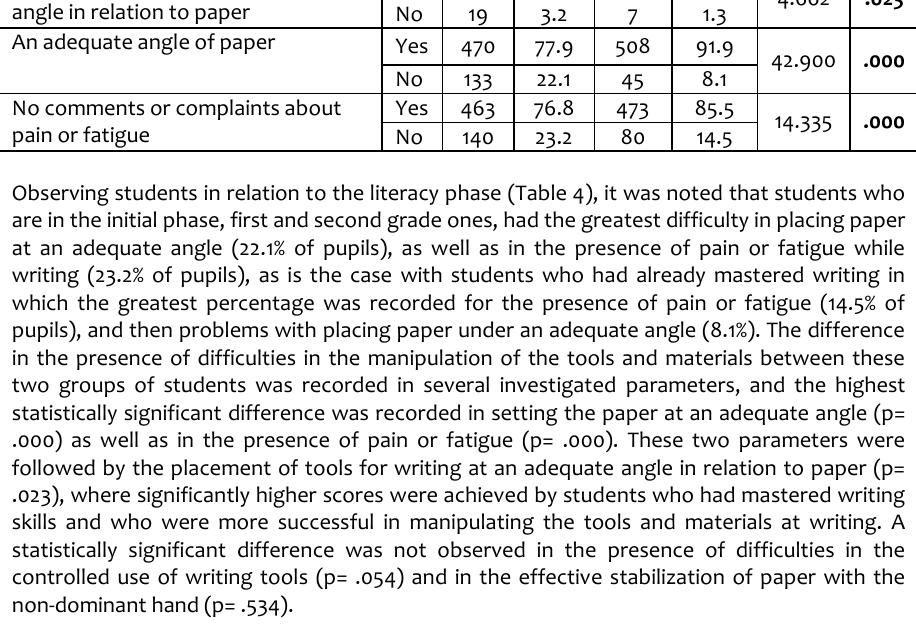
Table 4. Use of tools and materials in relation to the literacy phase Tools and materials